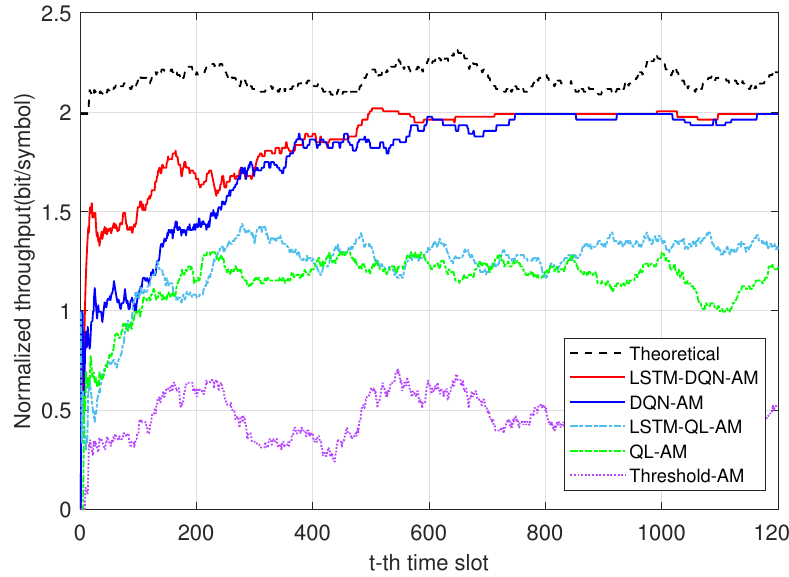
Figure 15. The throughput in the sea